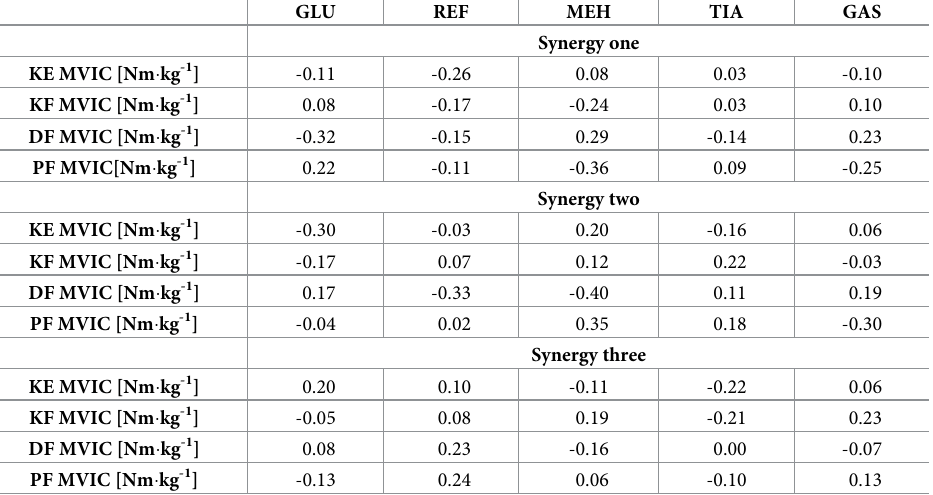
Table 3. Correlation between outcomes of strength measurement and synergy weights determined with Spear- man’s rank correlation coefficients ( ρ ) in DMD. GLU REF MEH TIA GAS Synergy one KE MVIC [Nm � kg -1 ] -0.11 -0.26 0.08 0.03 -0.10 KF MVIC [Nm � kg -1 ] 0.08 -0.17 -0.24 0.03 0.10 0.23 PF MVIC[Nm � kg -1 ] 0.22 -0.11 -0.36 0.09 -0.25 Synergy two KE MVIC [Nm � kg -1 ] -0.30 -0.03 0.20 -0.16 0.06 KF MVIC [Nm � kg -1 ] -0.17 0.07 0.12 0.22 -0.03 DF MVIC [Nm � kg -1 ] 0.17 -0.33 -0.40 0.11 0.19 0.18 -0.30 Synergy three -0.05 0.08 0.23 DF MVIC [Nm � kg -1 ] 0.08 0.23 -0.16 0.00 -0.07 -0.13 0.24 0.06 -0.10 0.13 Moderate to good correlations are in